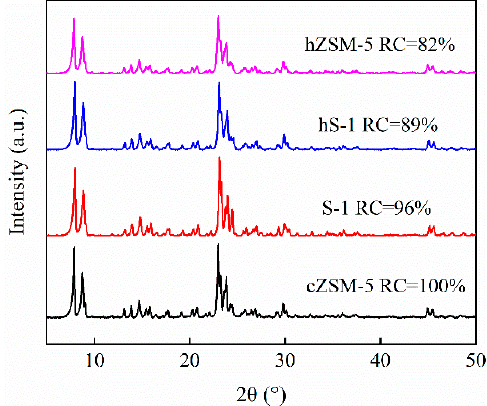
Figure 2. Powder XRD patterns of cZSM-5, S-1, hS-1, and hZSM-5 zeolites.